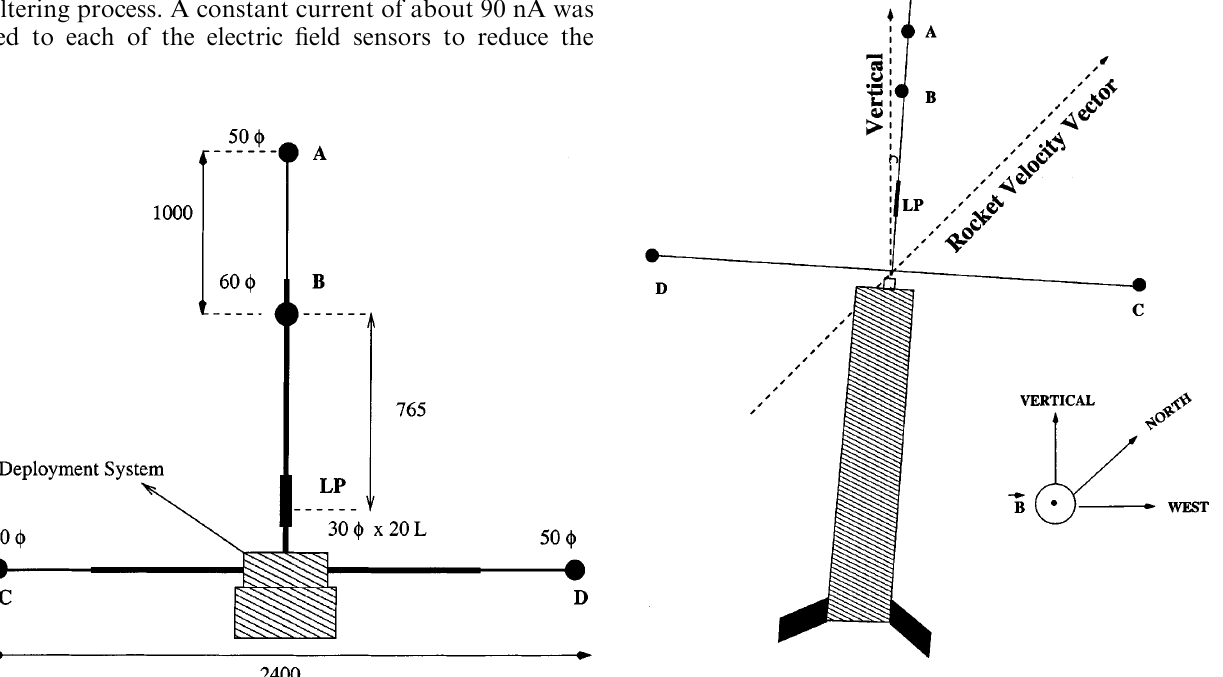
Fig. 2. Schematic of the location of electric field and the Langmuir probe sensors vis-a` -vis the directions of the magnetic field, the spin axis and the rocket velocity